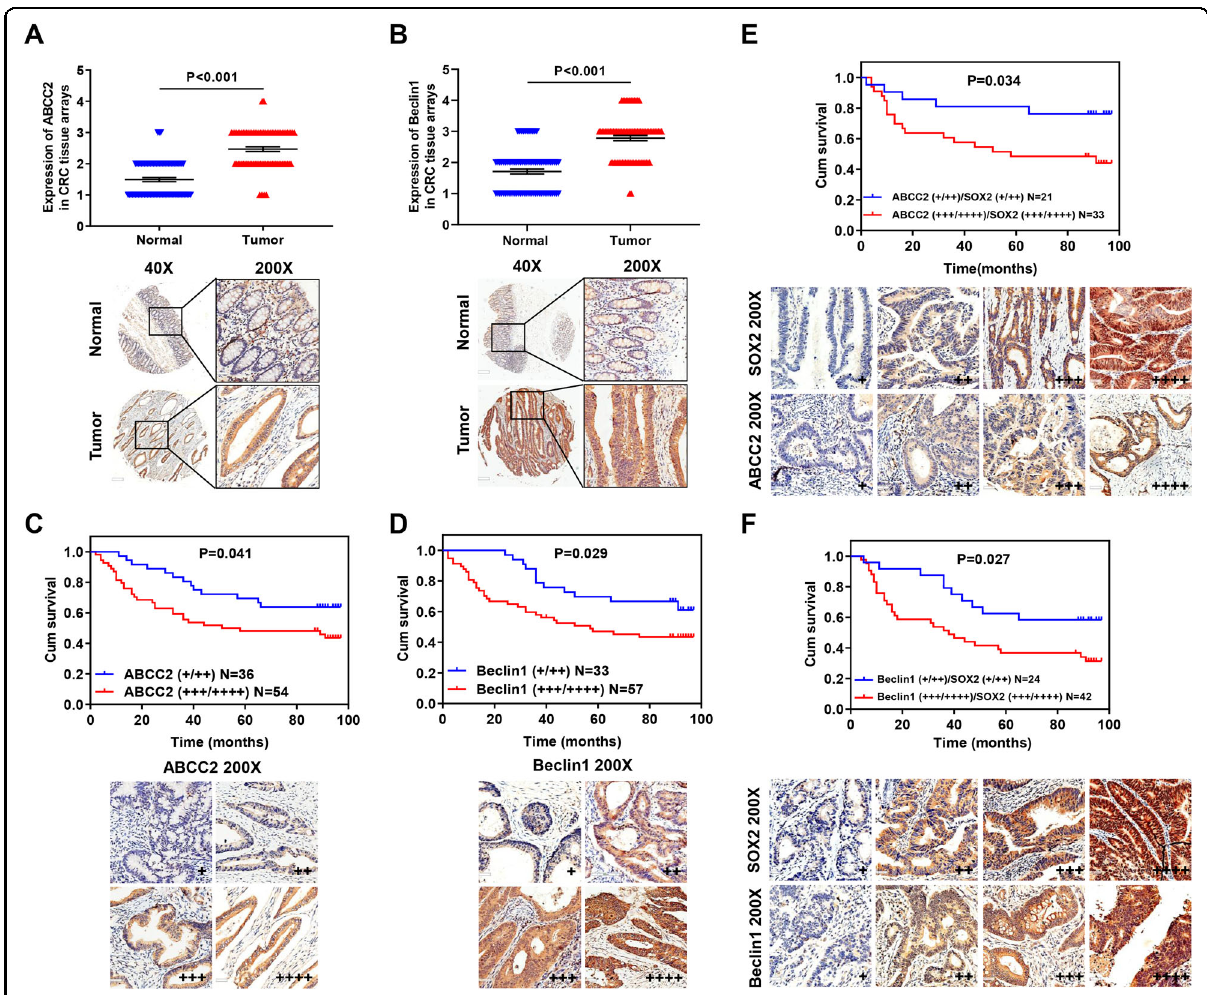
Fig. 6 The expression of SOX2, ABCC2, and Beclin1 in clinical samples. A , B The protein expression of ABCC2 ( A ) and Beclin1 ( B ) were examined by IHC in a microarray with 90 pairs of CRC tissues. C – F Survival curves were generated with Kaplan – Meier method according to the expression of ABCC2 ( C ), Beclin1 ( D ), both ABCC2 and SOX2 ( E ) as well as both Beclin1 and SOX2 ( F ). Log-rank analysis was used to test for signi fi cance.